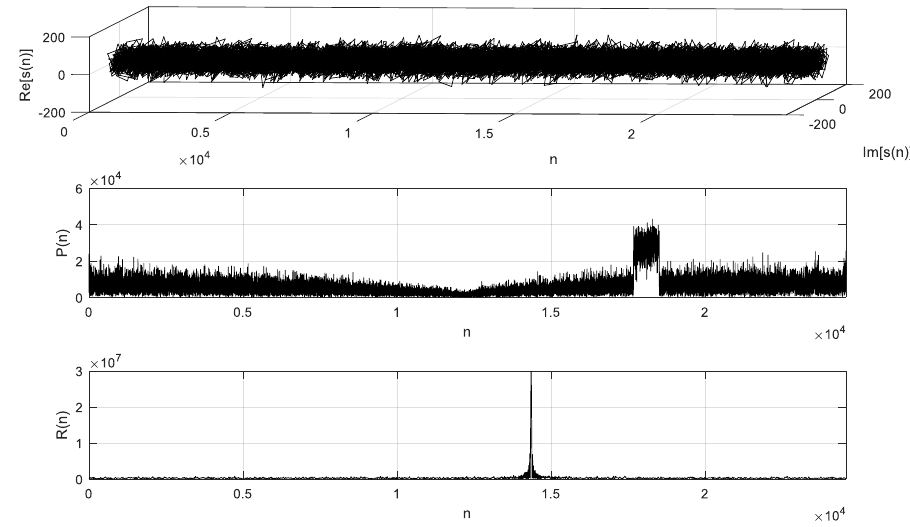
Figure 7. Time domain, power spectrum, and the corresponding correlation peak.